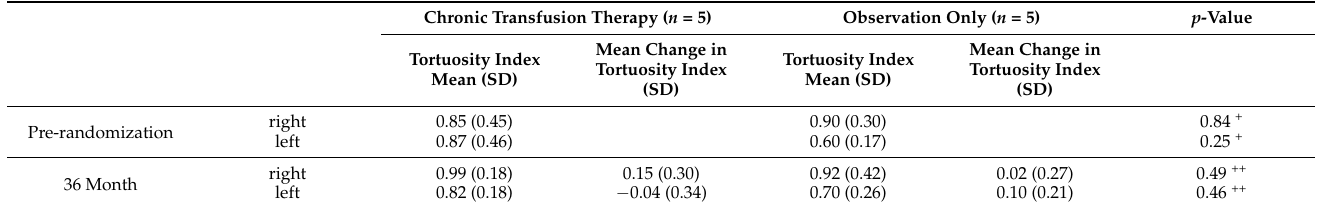
Table 3. Comparison of changes in tortuosity in observation and chronic RBC transfusion